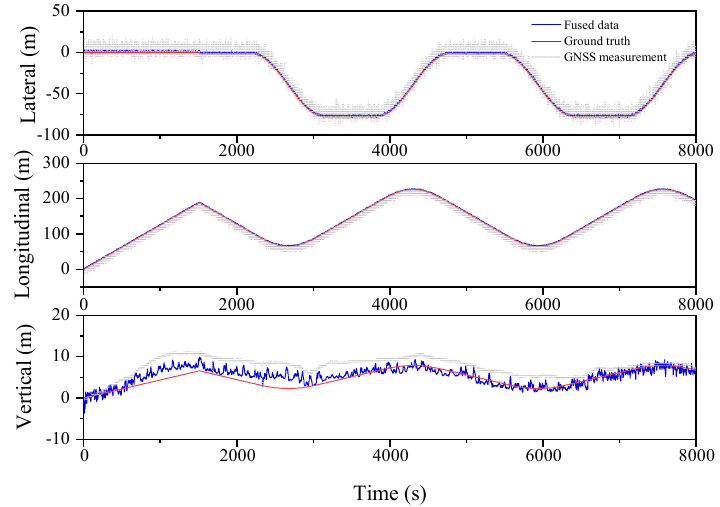
Figure 5. Lateral, Longitudinal and Vertical positions of ESKF–RTS (Oval).